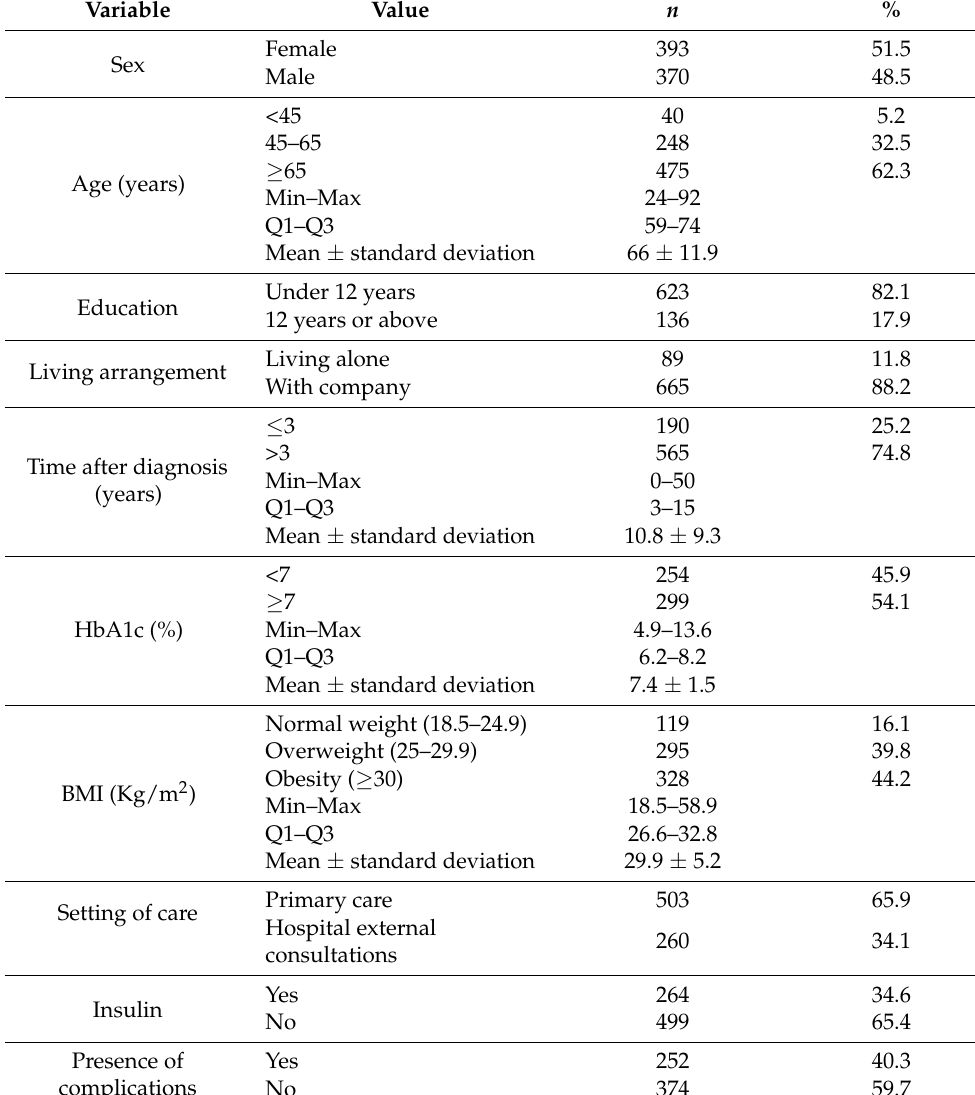
Table 1. Sociodemographic and clinical characteristics of the observed sample.